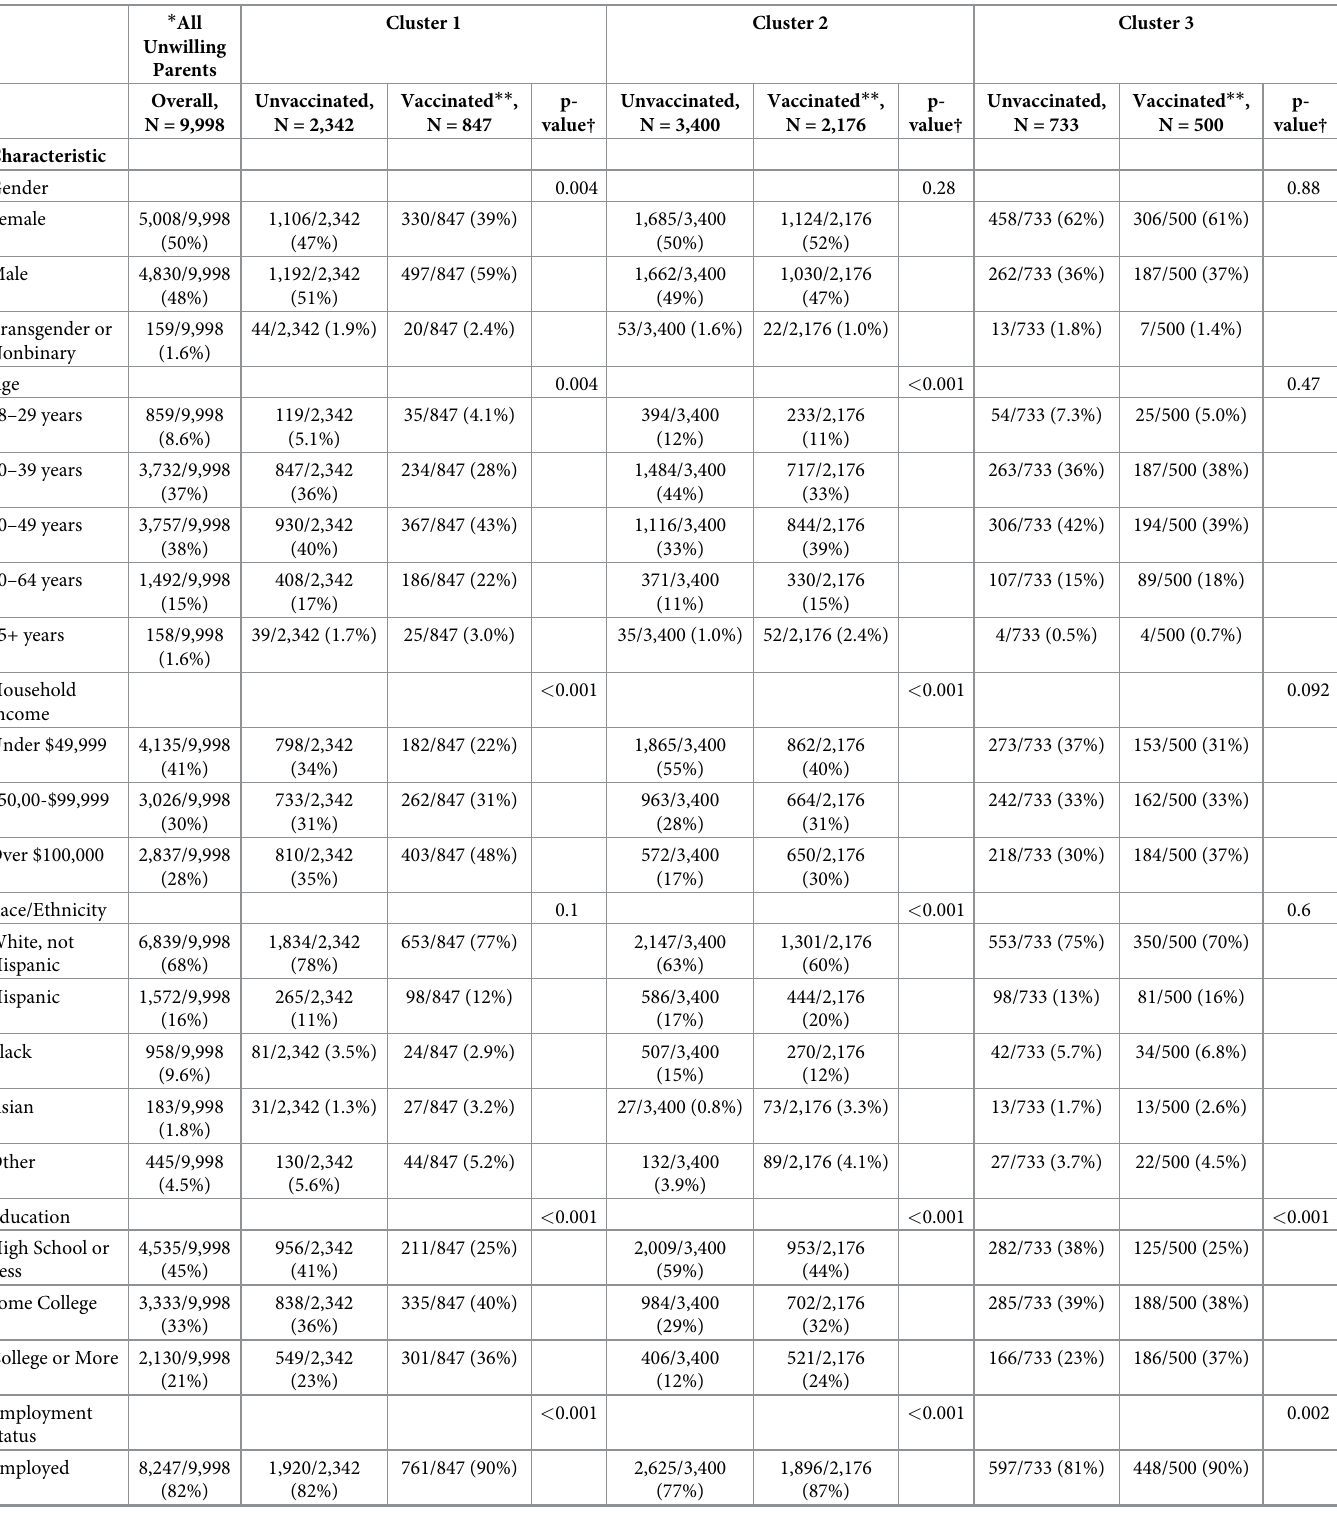
Table 3. Summary characteristics by clusters of unwilling